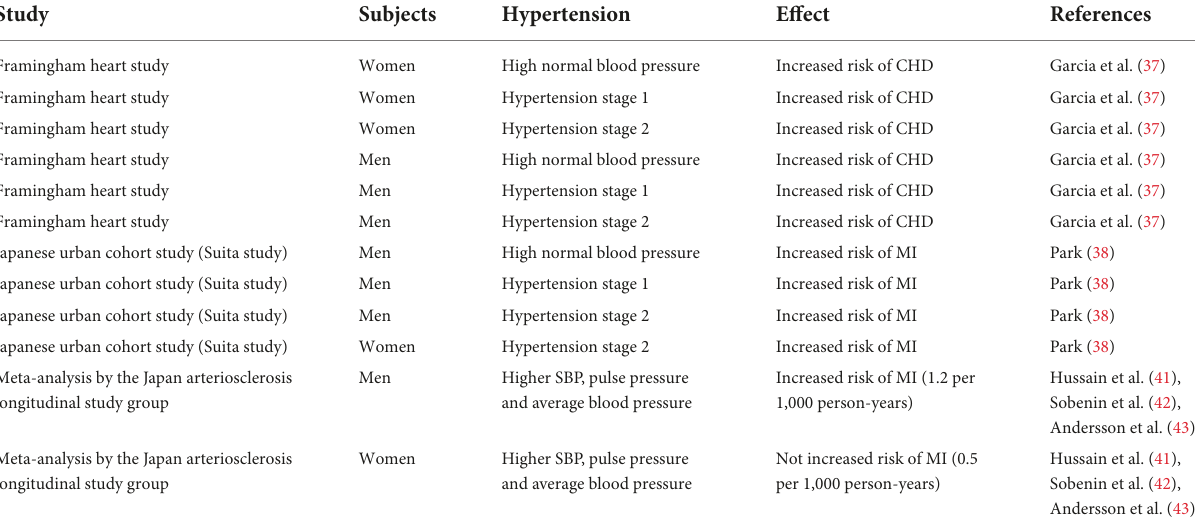
TABLE 1 Effects of various rates of hypertension on cardiovascular